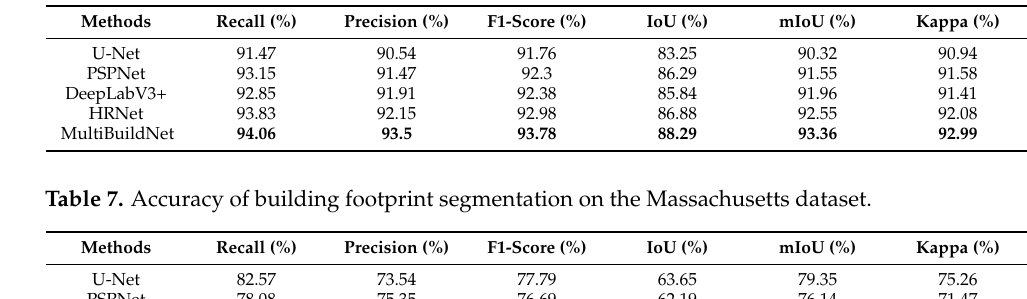
Table 6. Accuracy of building footprint segmentation on the WHU dataset.